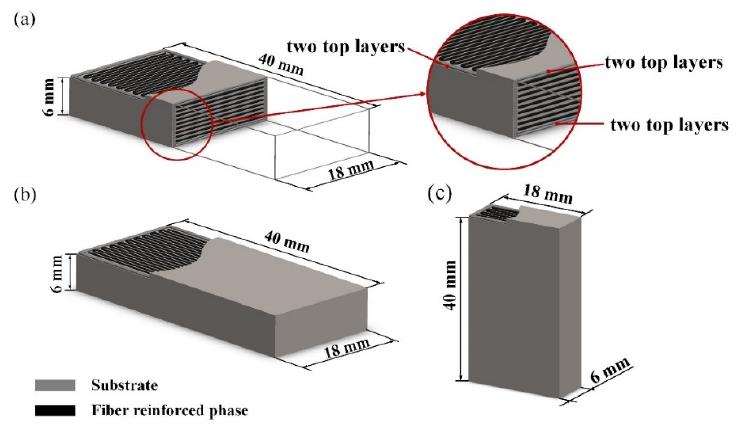
Figure 1. ( a ) Horizontal printing fiber 90° arrangement sample, ( b ) horizontal printing fiber 0° arrangement sample, ( c ) vertical printing fiber 0° arrangement sample.